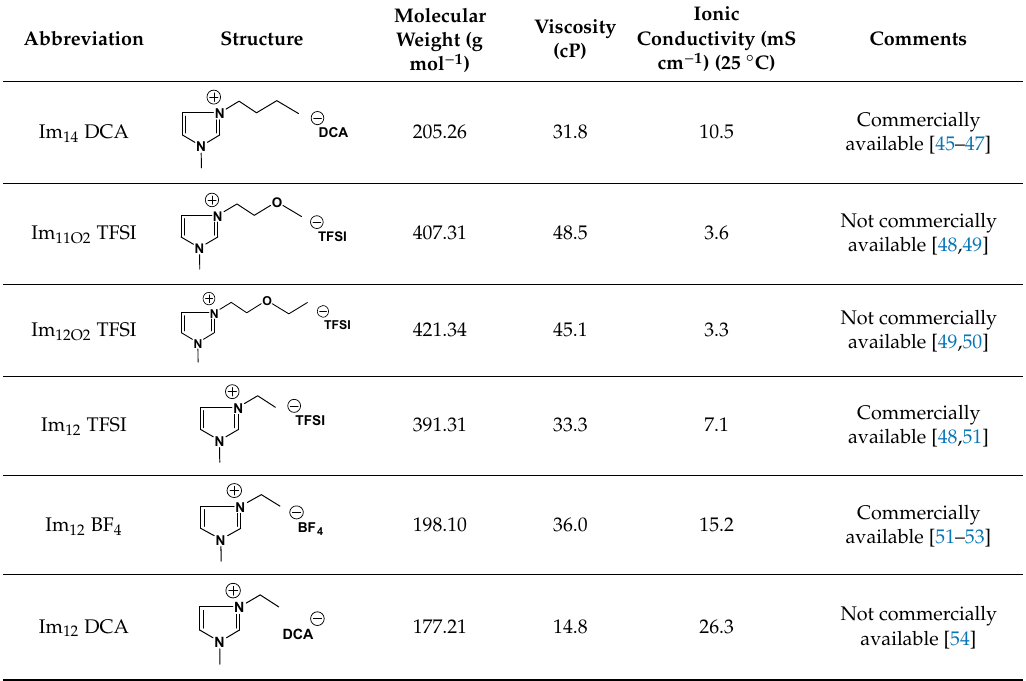
Table 2. Properties of Imidazolinium-based ILs.